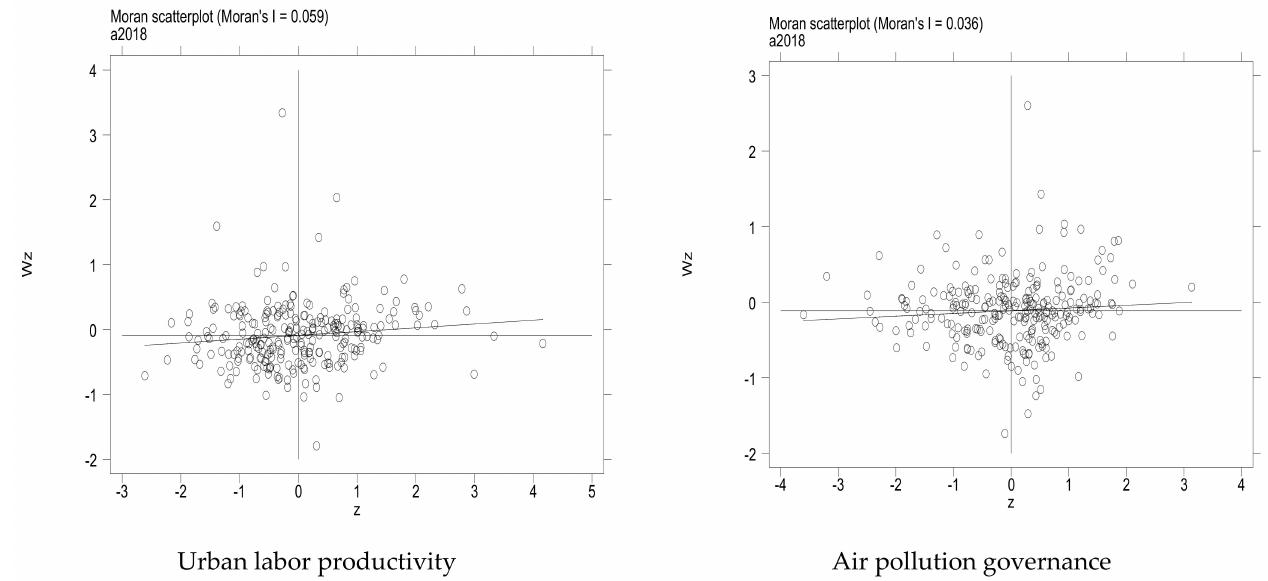
Figure 8. Scatter plot of Moran’s